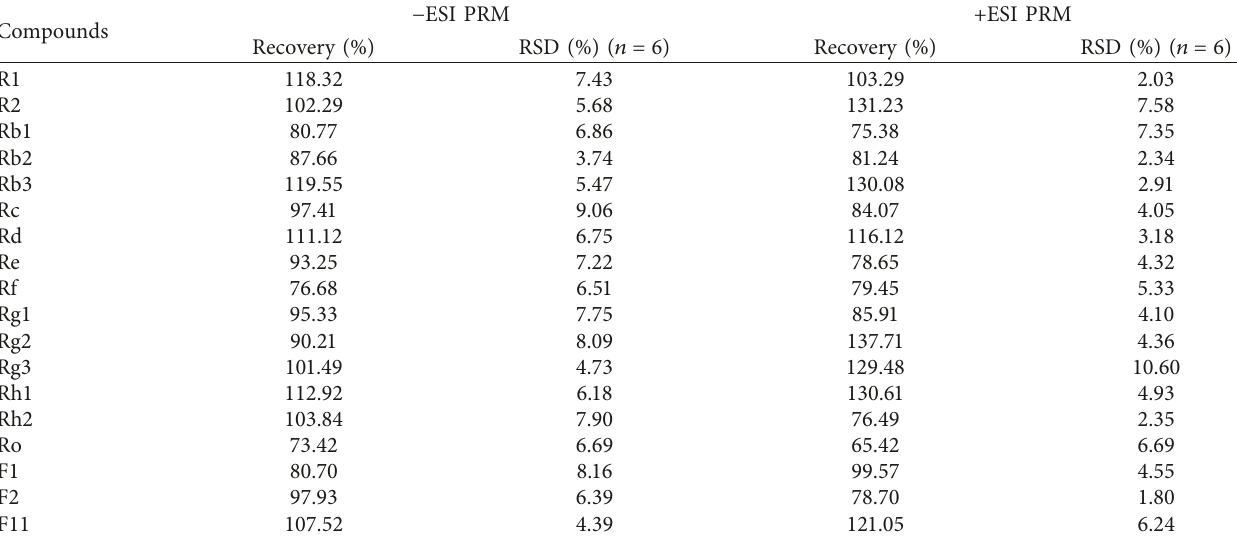
Table 7: Recovery for the eighteen ginsenosides in ginseng stem-leaf.